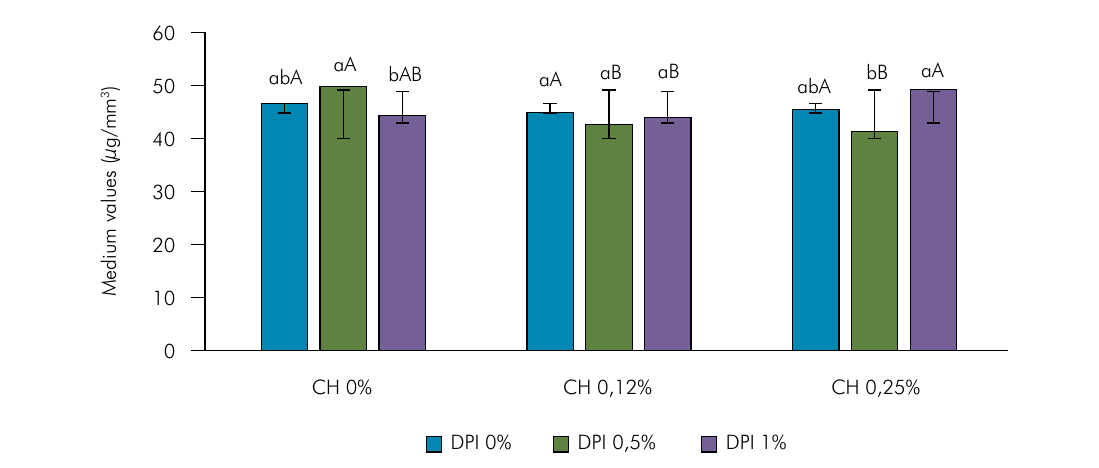
Figure 4. Mean values of water sorption ( μ g/mm 3 ) of experimental infiltrants, according to DPI (mol%) and chitosan (w%) concentrations.